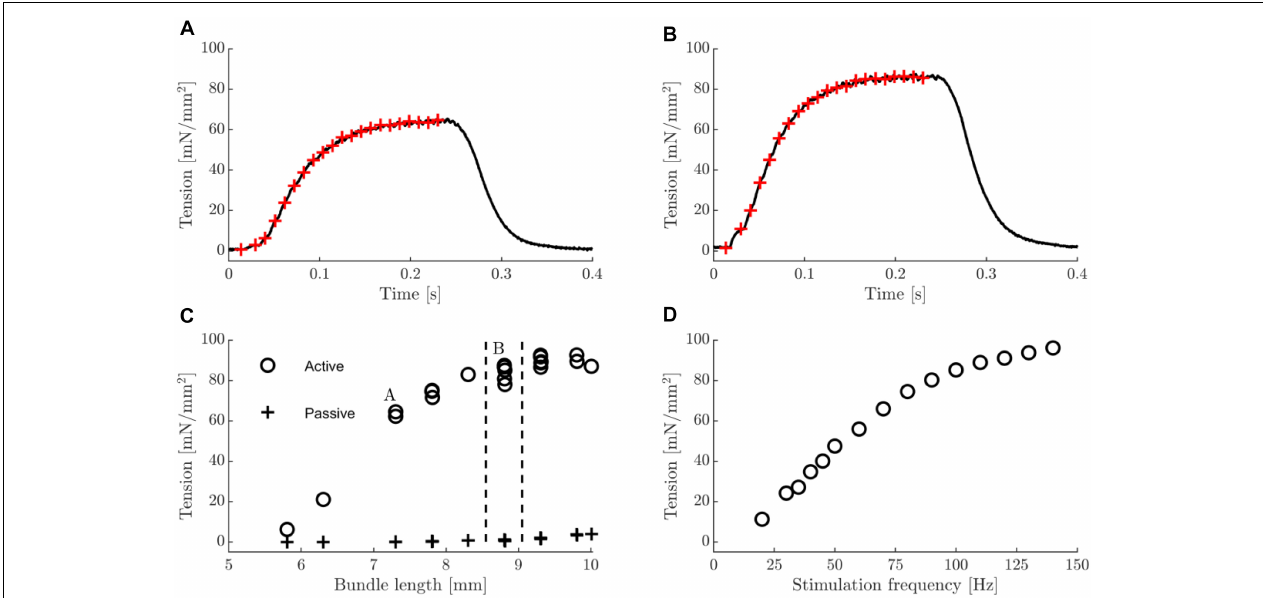
FIGURE 1 | Typical examples of tetanic contractions, tension-length and tension-stimulation frequency relation. (A) Tetanic contraction on ascending part of tension length relationship. (B) Tetanic contraction close to optimal fiber bundle length. In panels (A,B) , red crosses indicate times at which stimulus pulses were applied (stimulation frequency was 100 Hz). (C) Active and passive tension-length relationship. In the active condition, each tetanus consisted of 20 stimulus pulses delivered at 100 Hz. Vertical dashed lines indicate the range of bundle lengths encountered during the work loops in 0.25 mm amplitude conditions. The datapoints labeled A and B correspond to the data in panels (A,B) of this figure. Multiple data points corresponding to a single length indicate repeated trials. (D) tetanic tension-stimulation frequency relationship. Each tetanus consisted of 20 stimulus pulses.